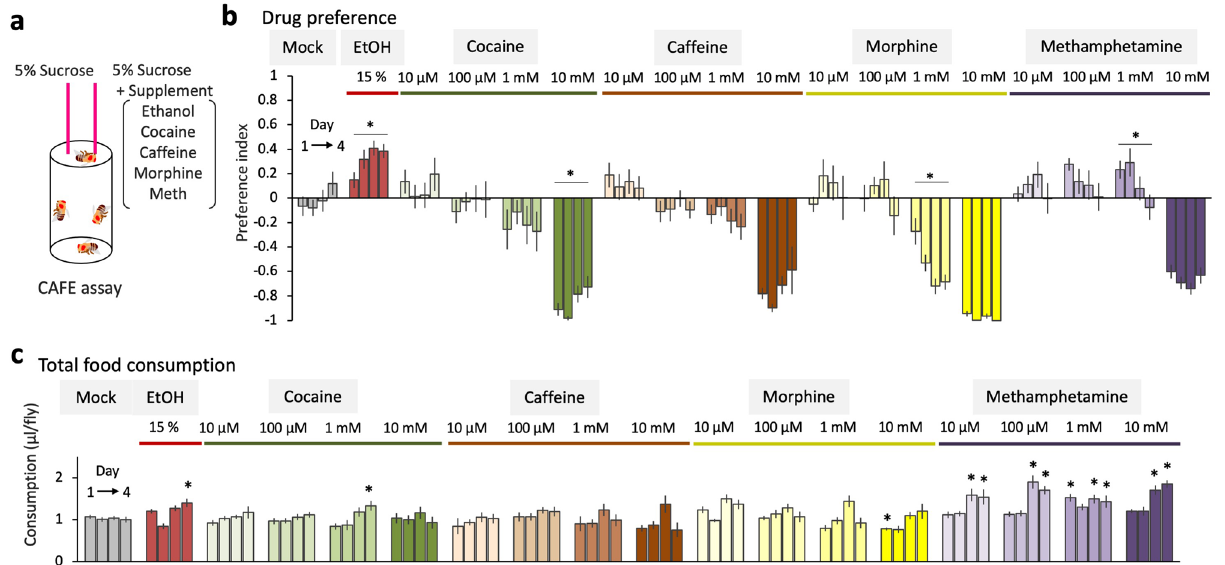
Figure 1. The Drosophila drug intake behavior. ( a ) Schematics of the two-choice CAFE assay. A group of four male flies is given a choice between 5% (w/v) sucrose solution and 5% sucrose solution supplemented with drugs. Daily consumption of each solution is measured as a descent of the meniscus for 4 days. ( b ) Preference indices of the wild type male flies are plotted from the day 1 to the day 4. Concentration of the drug is indicated above the bar graphs. One-way repeated-measures ANOVA or the Friedman test is performed among the indices from the day 1 to 4. 15% EtOH: F (2.654, 53.08) = 6.743, P = 0.0010, n = 21 (ANOVA); 10 µM cocaine: P = 0.3013, n = 11 (Friedman); 100 µM cocaine: F (1.610, 16.10) = 0.4848, P = 0.5845, n = 11 (ANOVA); 1 mM cocaine: F (1.433, 15.76) = 0.4714, P = 0.5700, n = 12 (ANOVA); 10 mM cocaine: P = 0.0088, n = 8 (Friedman); 10 µM caffeine: F (2.482, 27.30) = 0.4237, P = 0.7012, n = 12 (ANOVA); 100 µM caffeine: F (2.047, 18.42) = 0.7174, P = 0.5042, n = 10 (ANOVA); 1 mM caffeine: P = 0.2881, n = 11 (Friedman); 10 mM caffeine: P = 0.1904, n = 10 (Friedman); 10 µM morphine: F (1.880, 15.04) = 1.546, P = 0.2448, n = 9 (ANOVA); 100 µM morphine: F (2.025, 20.25) = 2.003, P = 0.1604, n = 11 (ANOVA); 1 mM morphine: P = 0.0011, n = 11 (Friedman); 10 mM morphine: F (1.522, 15.22) = 3.251, P = 0.0773, (ANOVA); 10 µM methamphetamine: F (2.100, 29.40) = 1.166, P = 0.3277, n = 15 (ANOVA); 100 µM methamphetamine: F (2.695, 43.12) = 1.816, P = 0.1634, n = 17 (ANOVA); 1 mM methamphetamine: F (2.450, 41.64) = 4.581, P = 0.0111, n = 18 (ANOVA); 10 mM methamphetamine: P = 0.2572, n = 15 (Friedman). Bar graphs: mean ± SEM. *: P < 0.05. ( c ) Daily food consumption per fly. Total consumption of the control and the drug solution is plotted. Consumption of each group is compared to that of the mock group on the same day (Two-stage linear step-up procedure of Benjamini, Krieger and Yekutieli). 15% EtOH: q = 0.3330, 0.7398,